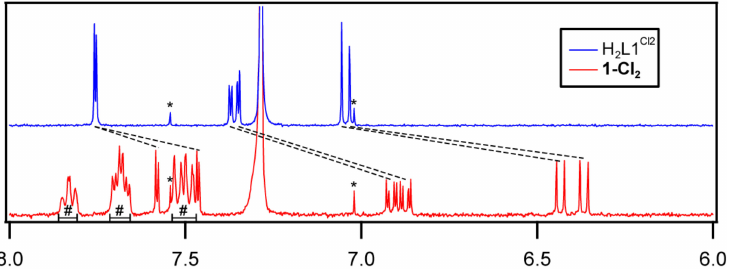
Figure 3. 1 H NMR spectra in the range of 8–6 ppm for ligand H 2 L1 Cl2 and Al III complex 1-Cl 2 in chloroform-d. * indicates spinning sidebands. # indicates signals from the TPP cation.